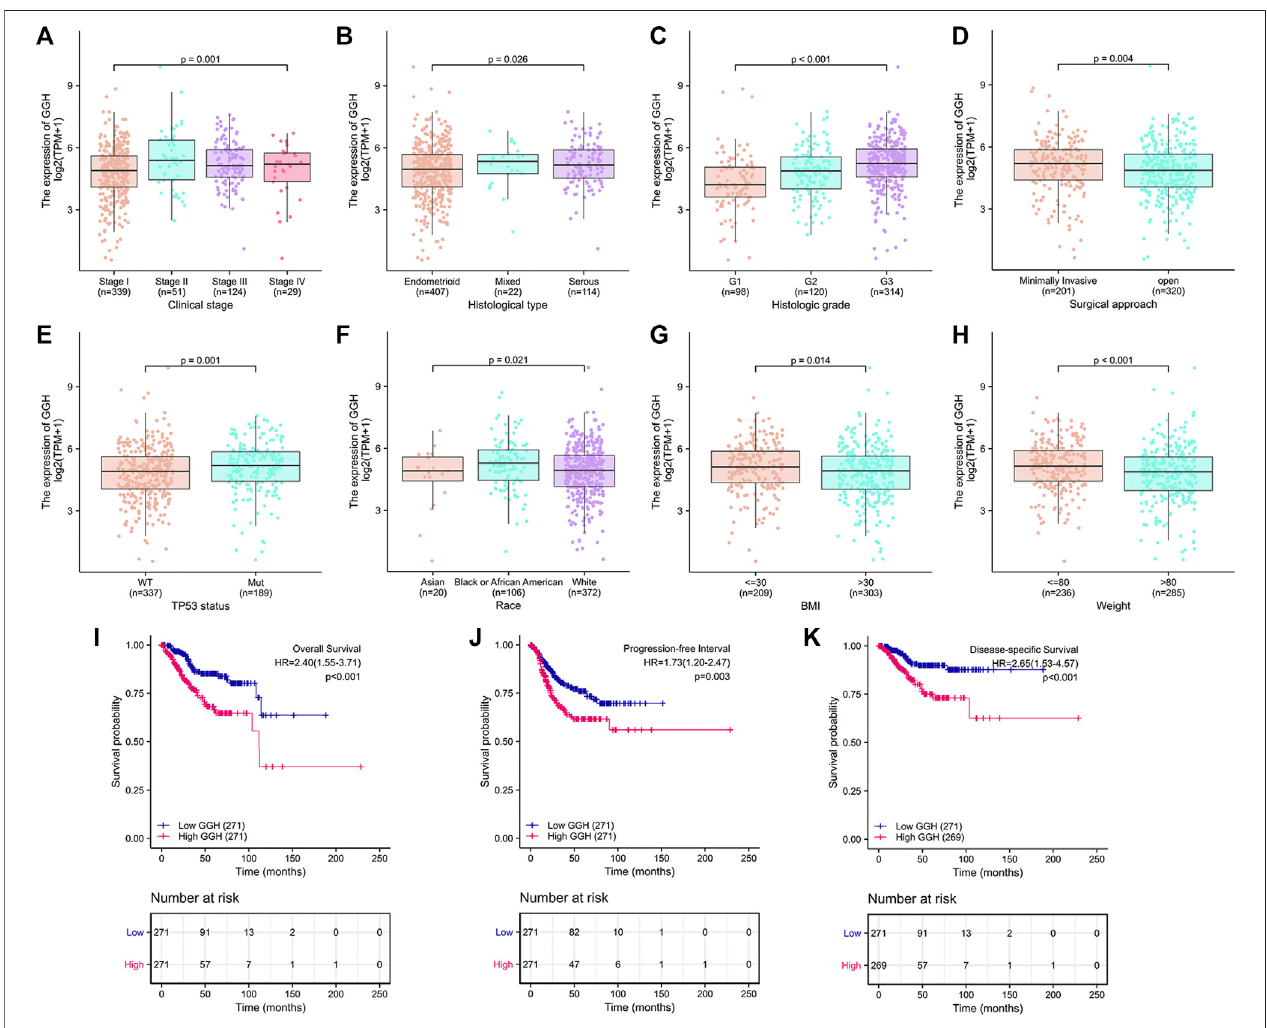
FIGURE 3 | Associations between GGH expression level and various clinicopathological factors, including patient outcome, from TCGA. (A – H) GGH expression level (low vs. high) was signi fi cantly associated with clinical stage ( n (cid:1) 543 total cases, p (cid:1) 0.001), histological type ( n (cid:1) 543, p (cid:1) 0.026), histological grade ( n (cid:1) 532, p < 0.001), surgical approach ( n (cid:1) 521, p (cid:1) 0.004), TP53 mutation status ( n (cid:1) 526, p (cid:1) 0.001), race ( n (cid:1) 498, p (cid:1) 0.021), BMI ( n (cid:1) 512, p (cid:1) 0.014), and weight ( n (cid:1) 521, p < 0.001). (I – K) Kaplan-Meier analysis indicated poorer OS, PFI, and DSS among UCEC patients with high GGH mRNA expression. HR, hazard ratio; OS, overall survival; PFI, progression-free interval; DSS, disease-speci fi c